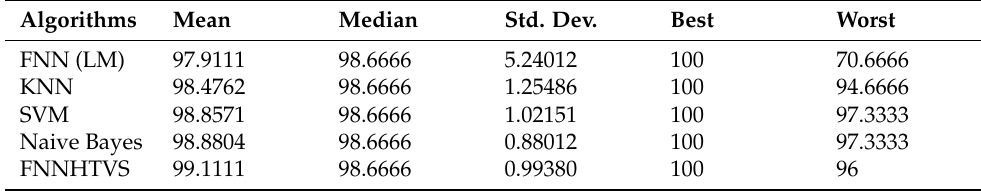
Table 10. Statistical results showing the accuracy of FNNHTVS and other